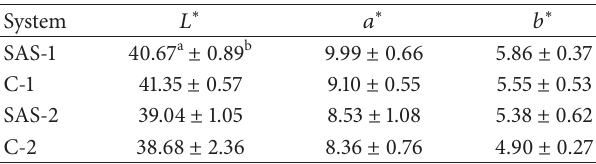
Table 3: Color determination in dry sausages at the end of the ripening